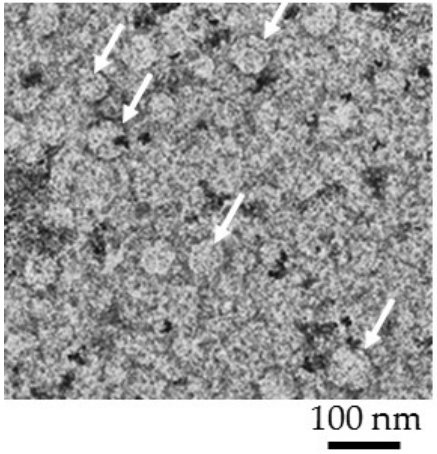
Figure 2. Transmission electron-microscopic observation of extracellular vesicles s at a concentration of 9.0 × 10 7 particles/1 mL. Average size of an extracellular vesicle was ~50–75 nm. The white arrows pointed to an extracellular vesicle. The Formar carbon copper grid was imaged using FEI Talos F200X Transmission Electron Microscope with a lattice-fringe resolution of 0.14 nm at an accelerating voltage of 200 kV equipped with CETA 16M